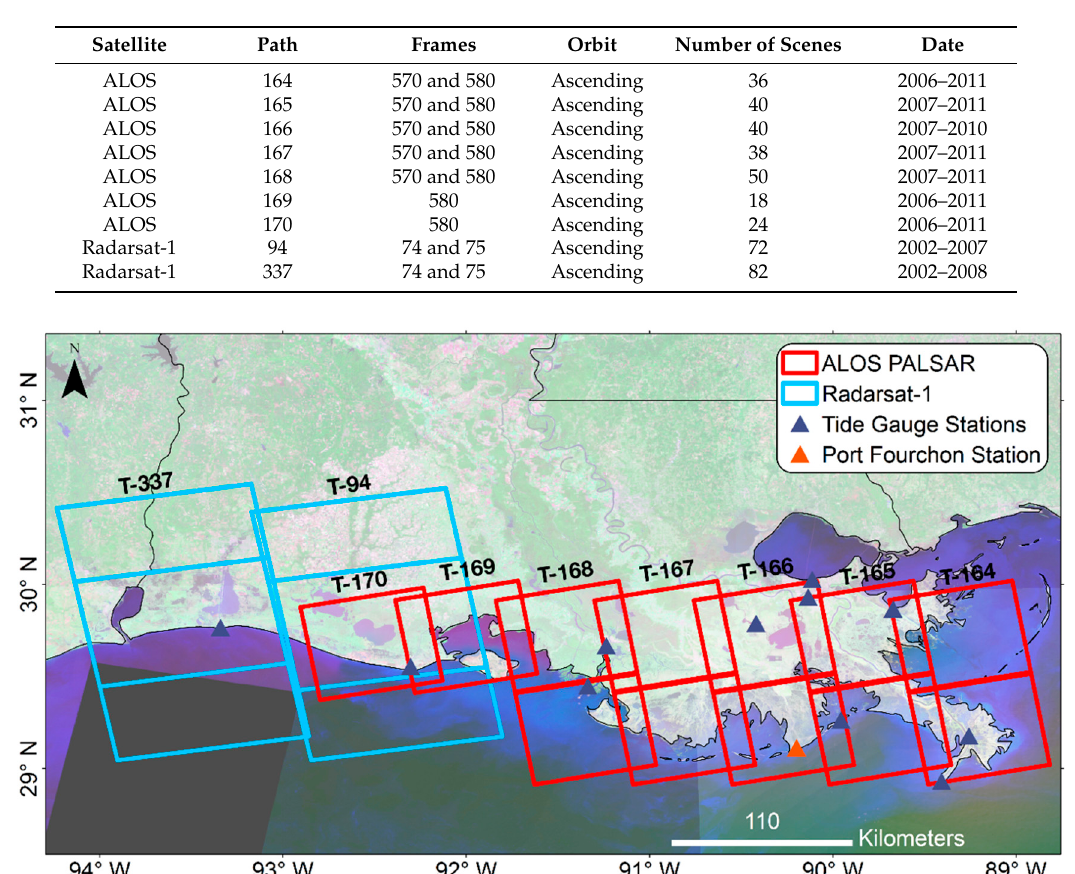
Table 1. Scenes available and satellite information.